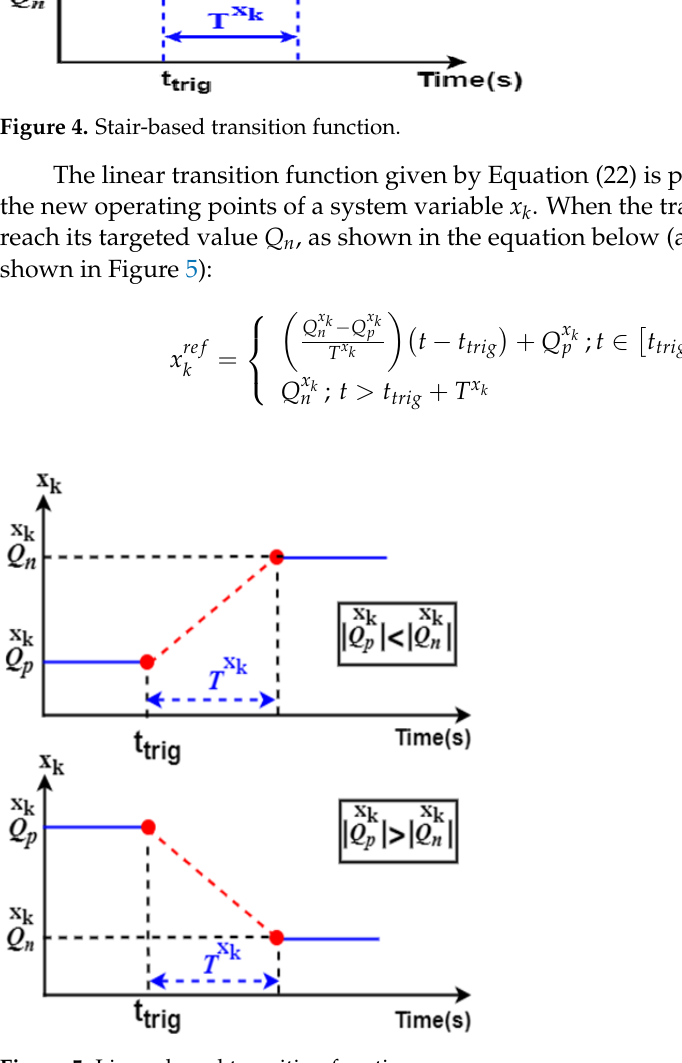
Figure 6. STA flowchart.